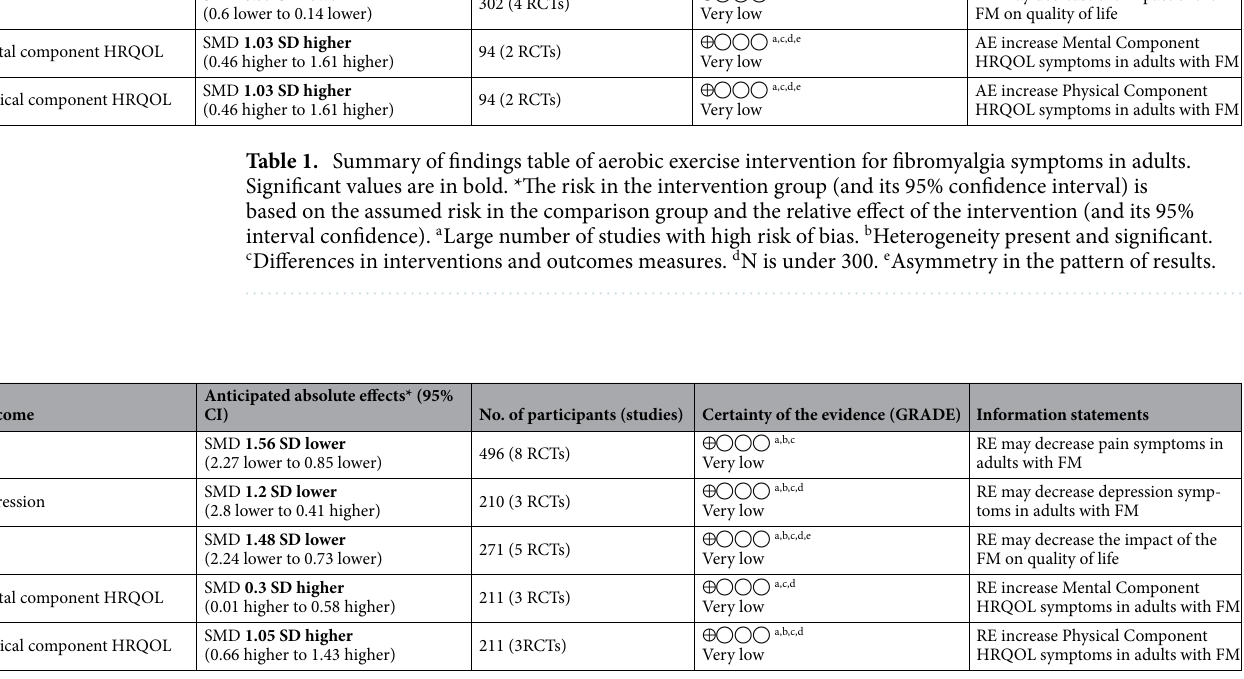
Table 2. Summary of findings table of resistance exercise intervention for fibromyalgia symptoms in adults. Significant values are in bold. *The risk in the intervention group (and its 95% confidence interval) is based on the assumed risk in the comparison group and the relative effect of the intervention (and its 95% interval confidence). a Large number of studies with high risk of bias. b Heterogeneity present and significant. c Differences in interventions and outcomes measures. d N is under 300. e Asymmetry in the pattern of